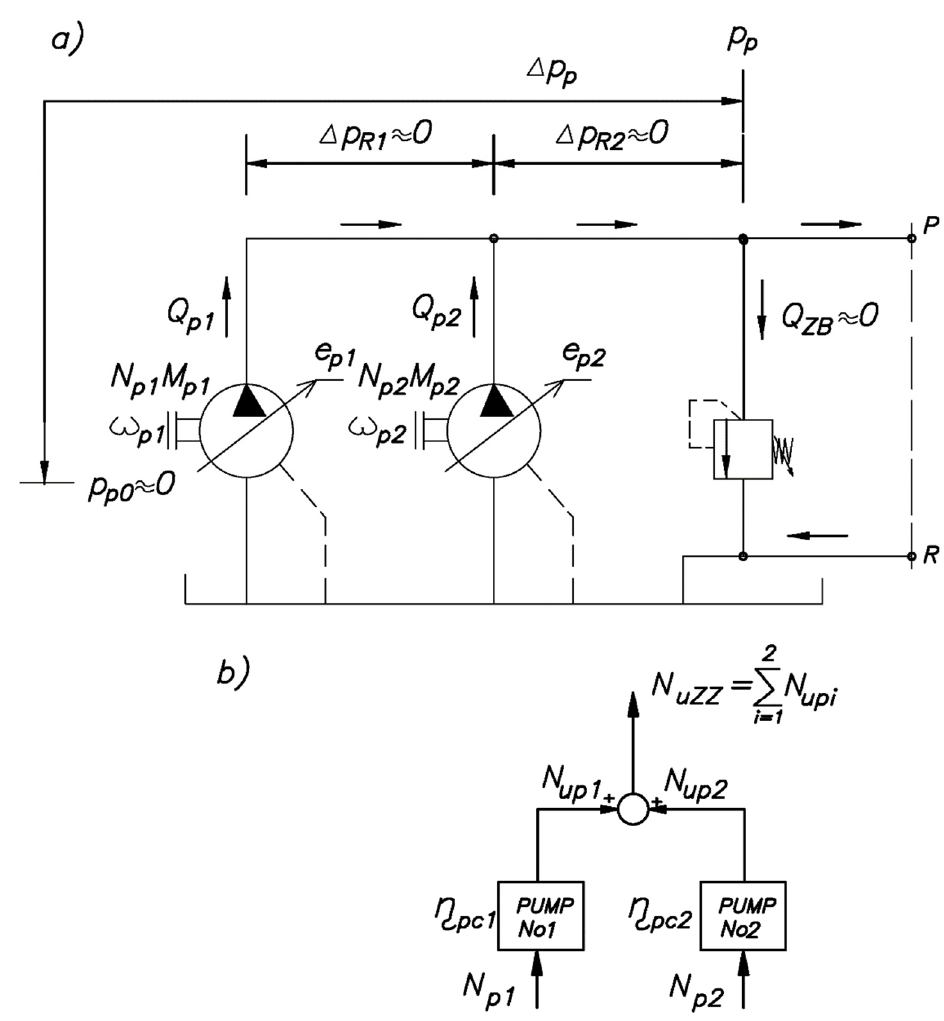
Figure 5. Diagram of a hydraulic supply system with two pumps of variable specific capacity operating in an open circuit. P—pressure connection to the supply unit, R—connection of the supply unit to the return system. ( a ) Simplified hydraulic diagram and ( b ) block diagram. Source: own preparation.